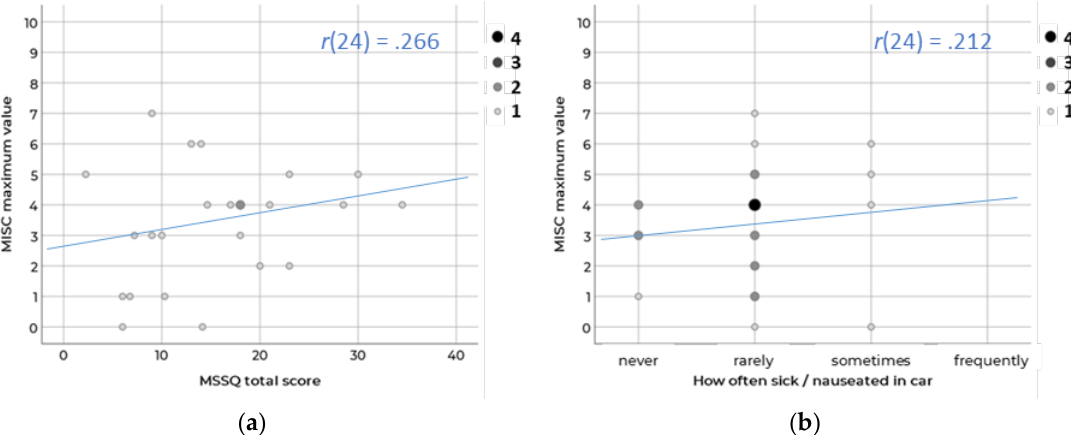
Figure 3. Spearman correlation between the maximum value on the misery scale during the session and ( a ) the MSSQ total score and ( b ) the single item concerning sickness in cars. Size and color of the dot indicate the number of respondents.